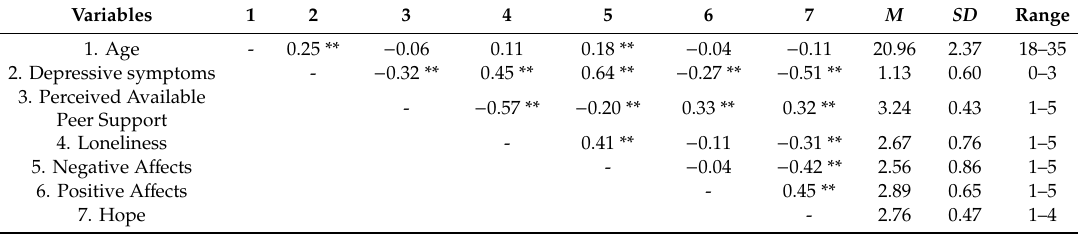
Table 1. Descriptive statistics and correlations of